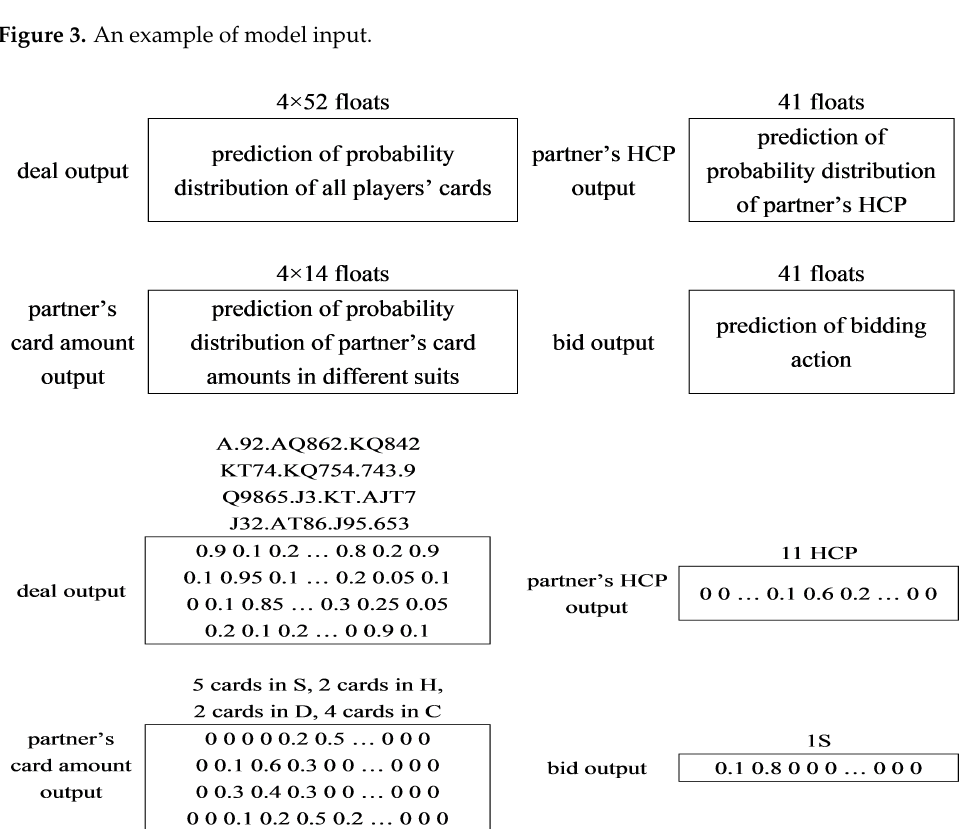
Figure 4. An example of model